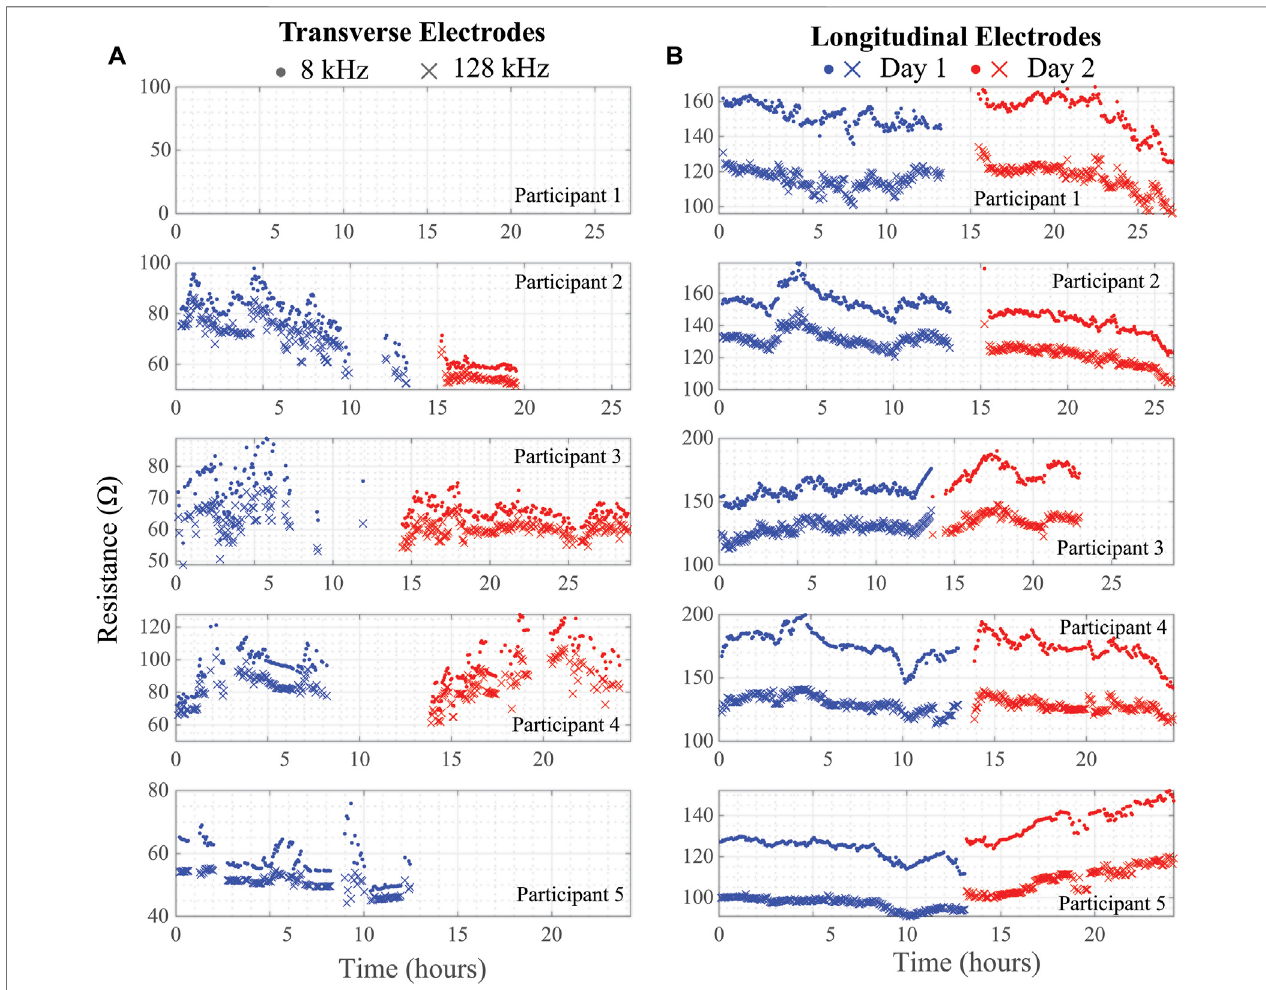
FIGURE 7 | (A) Transverse and (B) longitudinal knee tissue resistance (8 kHz, 128 kHz) collected during free-living across 2 days from 5 healthy adult participants using wearable sensing system.